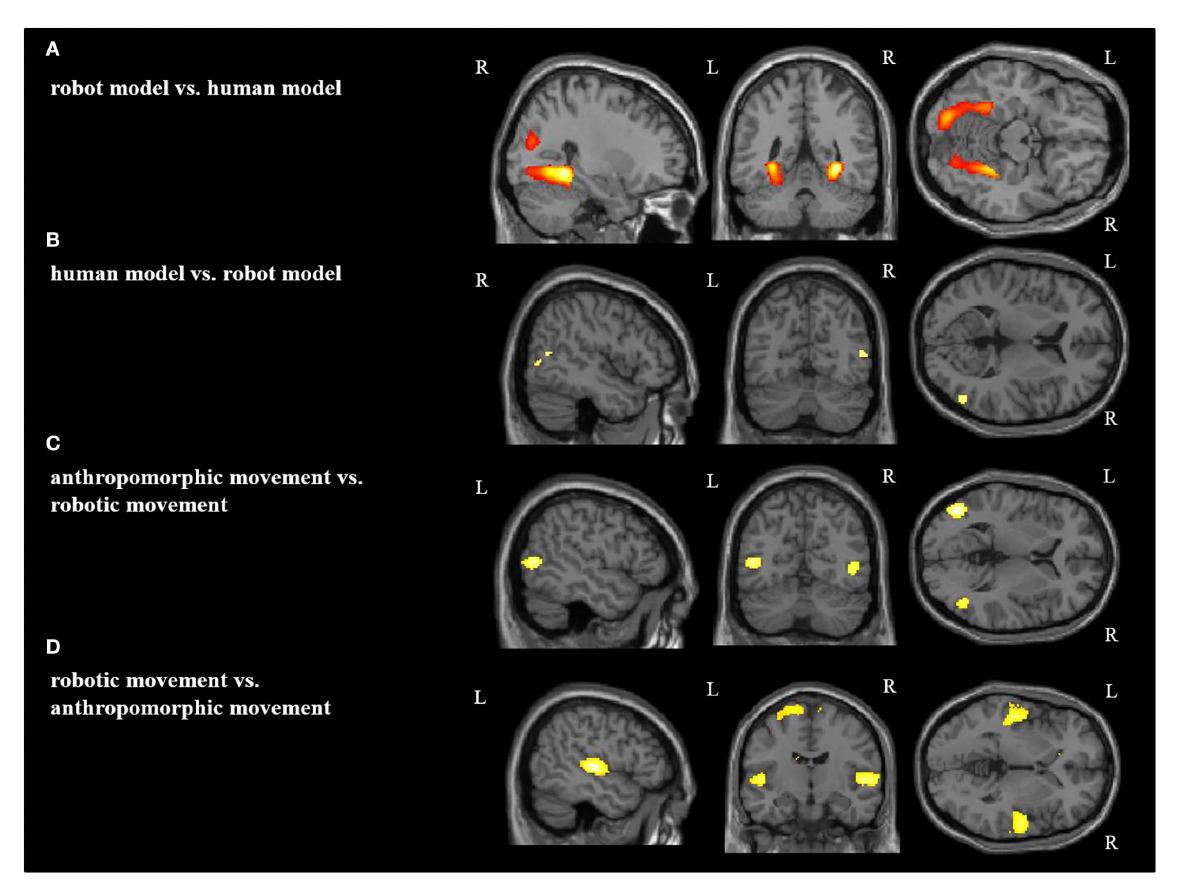
FIGURE4 Main effect for each condition: (A) robot model vs. human model, (B) human model vs. robot model, (C) anthropomorphic movement vs. robotic movement, (D) robotic movement vs. anthropomorphic movement in the right (R) and left (L) hemisphere [ p < 0.05 (FWE), k =